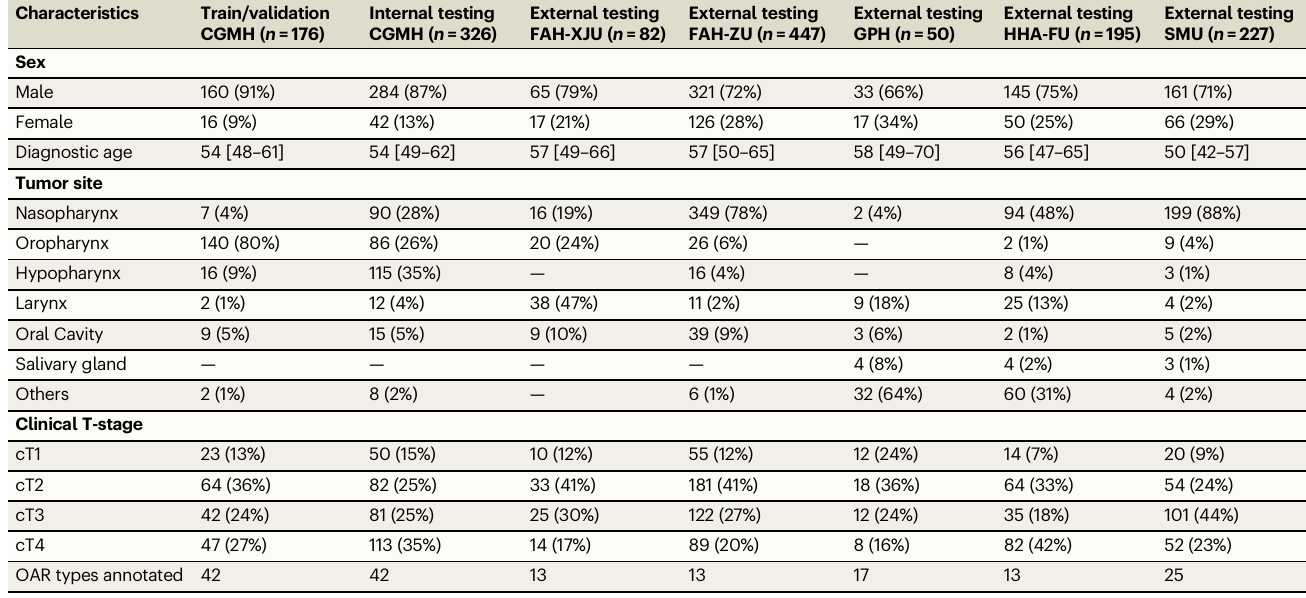
Table 1 | Subject characteristics Characteristics